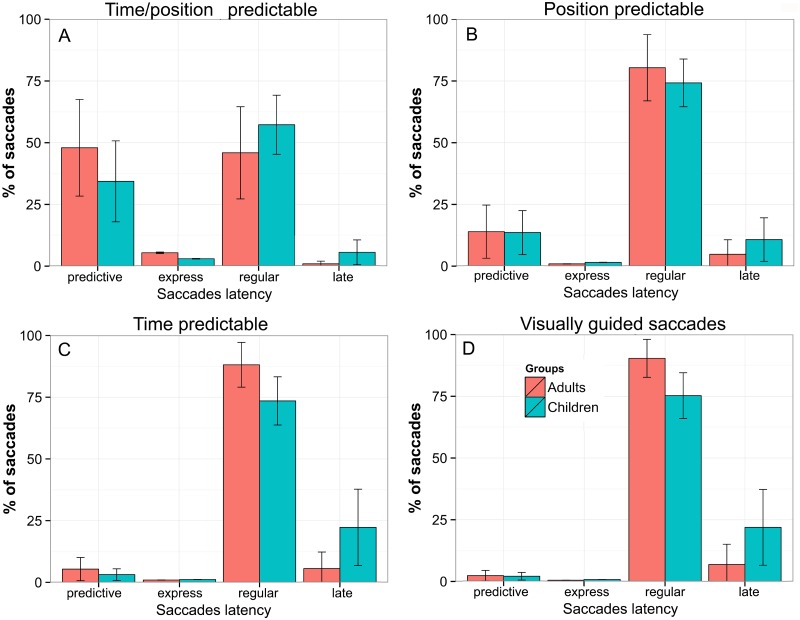
The saccades distribution for each task.The task dependent change in ocular motor pattern is displayed as the proportion of saccades (graph y-axis) generated the latency groups: predictive (-300 to 80ms), express (80 to 120ms), regular (120 to 350ms) or late saccades (350 to 500ms). The proportion of saccadets is displayed for each task and group (children and adults): (A) PRED, (B) pPRED, (C) tPRED and (D) SAC. The error bars represent the Standard Deviation.